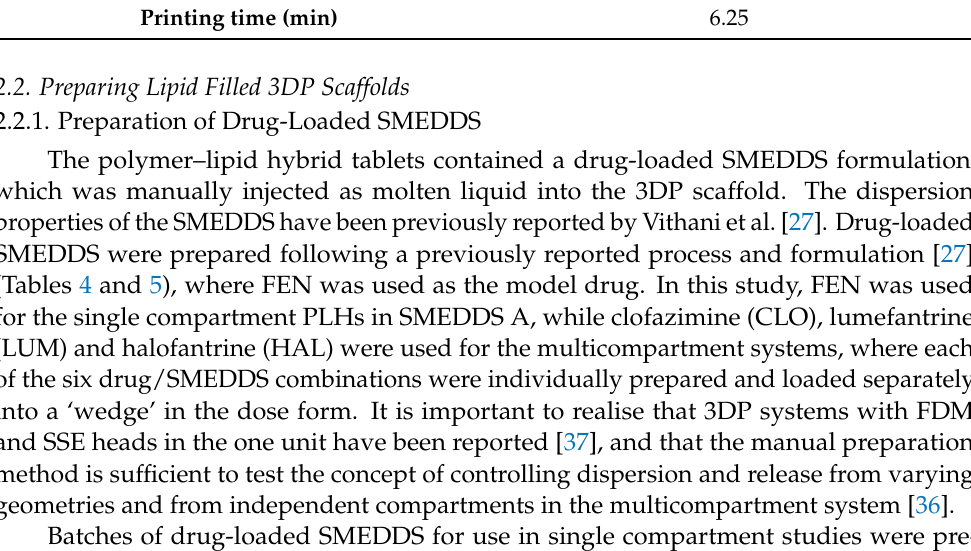
Table 4. Compositions of the FEN-loaded SMEDDS used for the single-compartment systems.